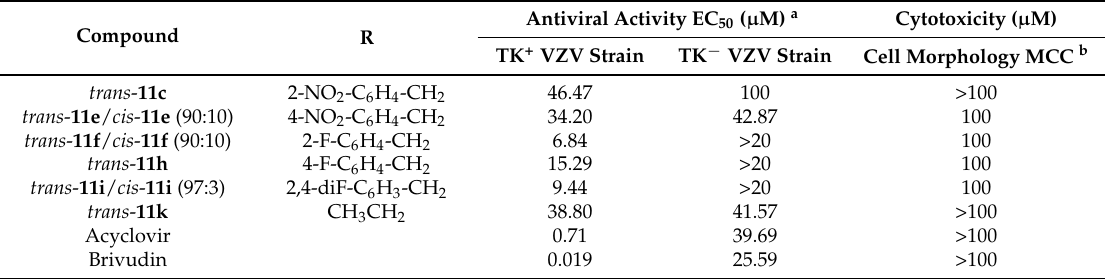
Table 2. Cytotoxicity and antiviral activity against varicella-zoster virus (VZV) in HEL cell cultures.